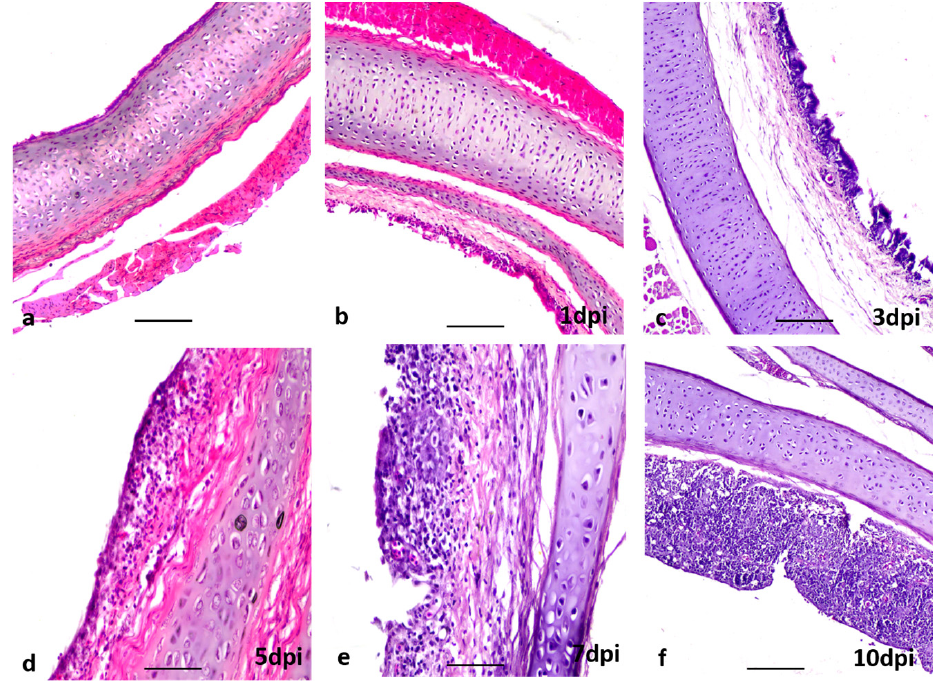
Figure 3. Section of trachea of chickens; ( a ) uninfected, no lesions, ( b – f ) infected with LPAI, ( b ), no lesions at 1 dpi, ( c ) mild tracheitis with partly sloughing of mucosa, ( d ) moderate to severe tracheitis, ( e , f ) severe tracheitis. H & E stain, bar: ( a – c , f ) =100 µ m; ( d , e ) = 20 µ m.